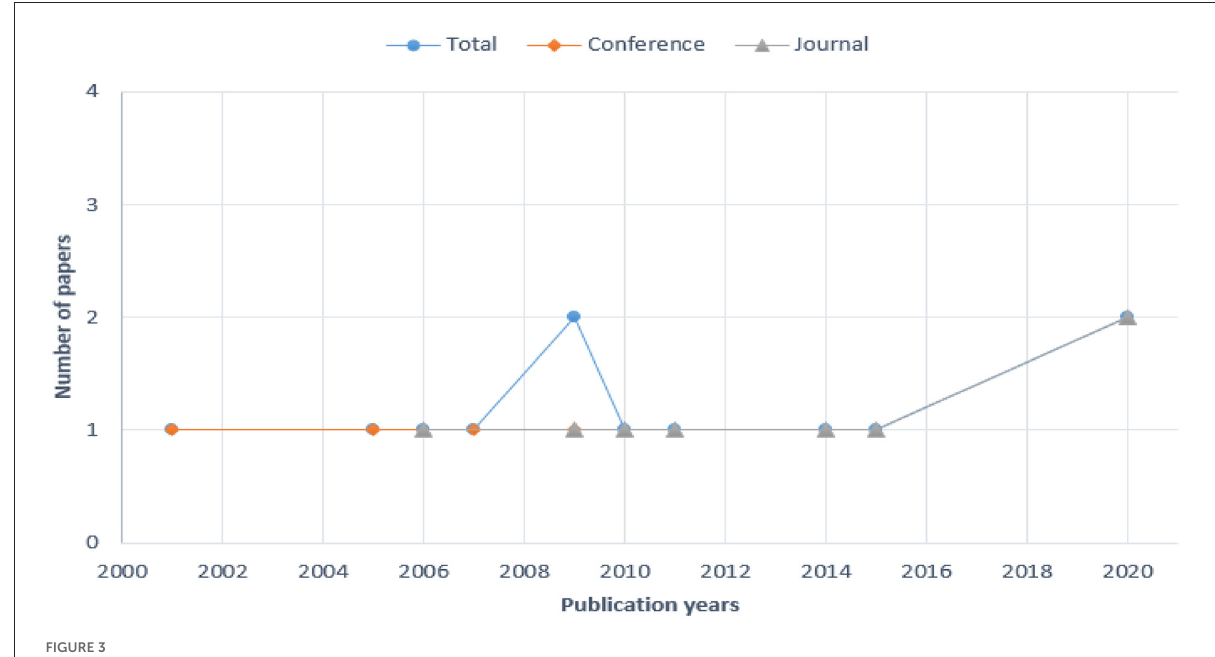
FIGURE3 Number of papers per